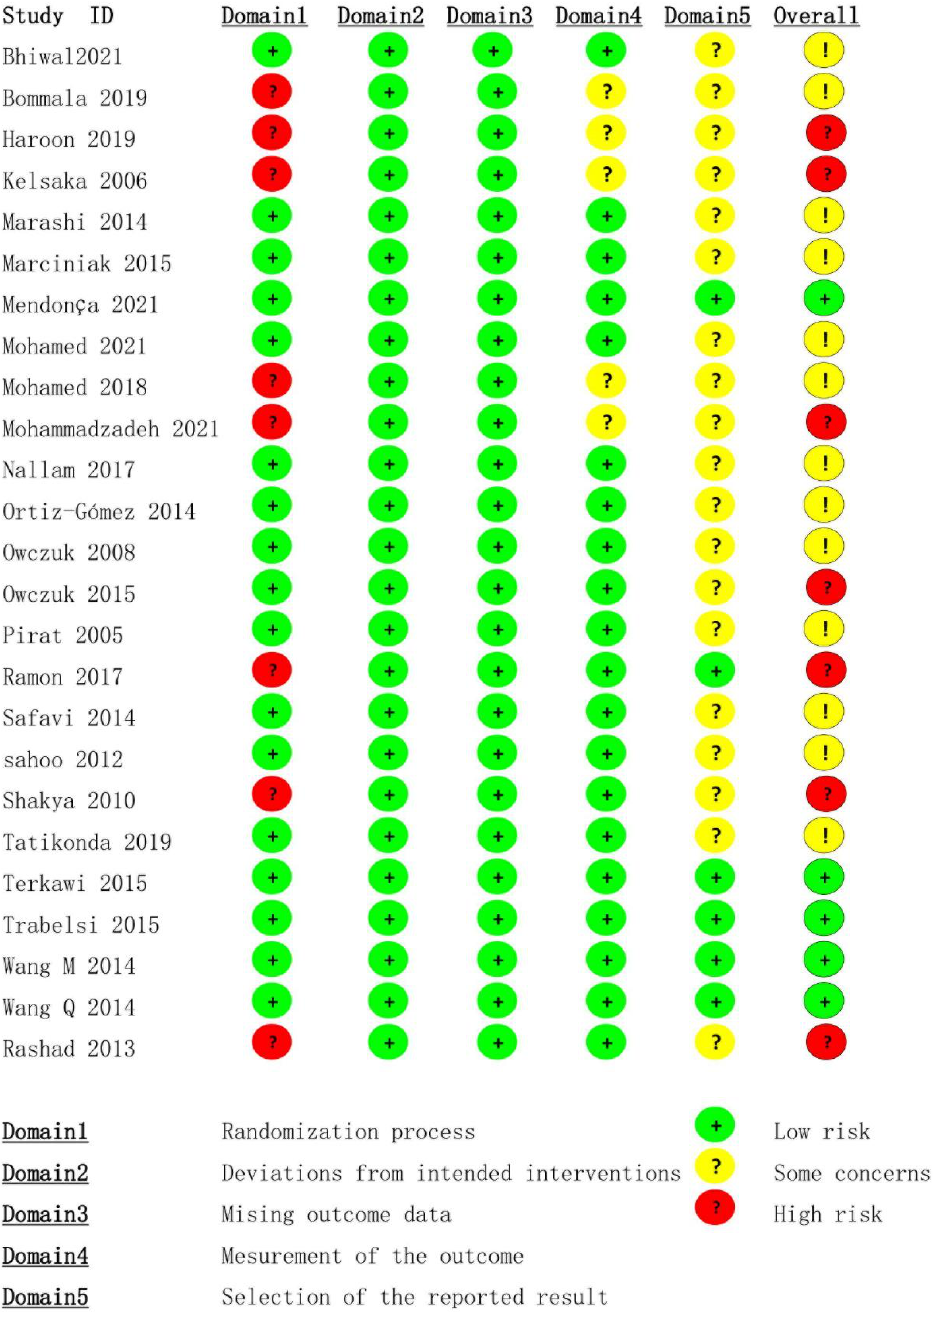
Figure 2. Summary of the risk of bias results for the included studies.[2, 11-13, 30-50]